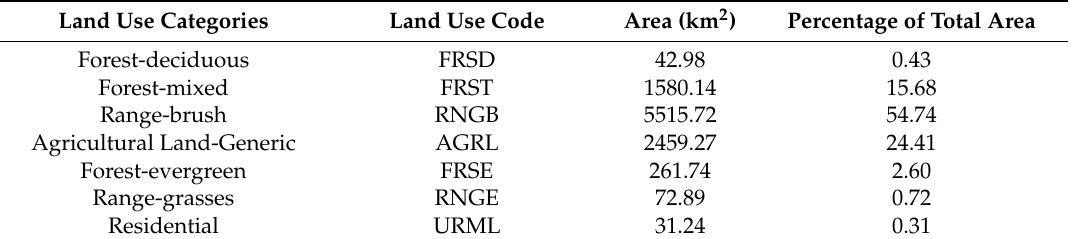
Table 1. Land use/cover classes, their area, and percentage of total area for the Ouémé-Bétérou catchment (10,076 km 2 ). Land use categories displayed in table are the most important land classes in the study area.